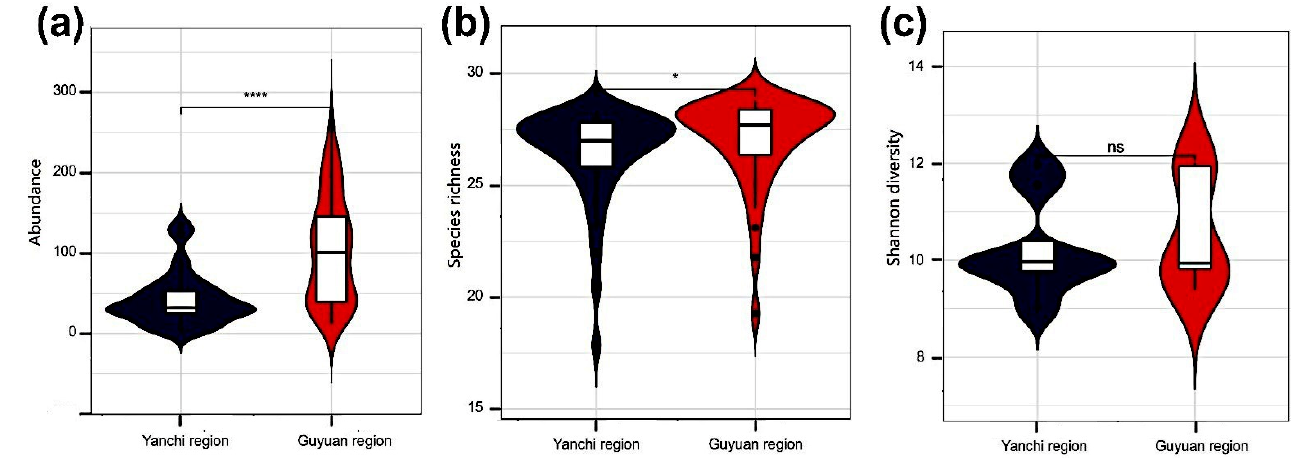
Figure 3. Violin plots showing probability densities of ( a ) abundance, ( b ) species richness, and ( c ) Shannon diversity. The boxplots inside violins represent the distribution of measured data and show the median, and the lower and upper limits. Adjusted p -values are indicated as * p < 0.05; **** p < 0.0001; ns, not significant ( p > 0.05).